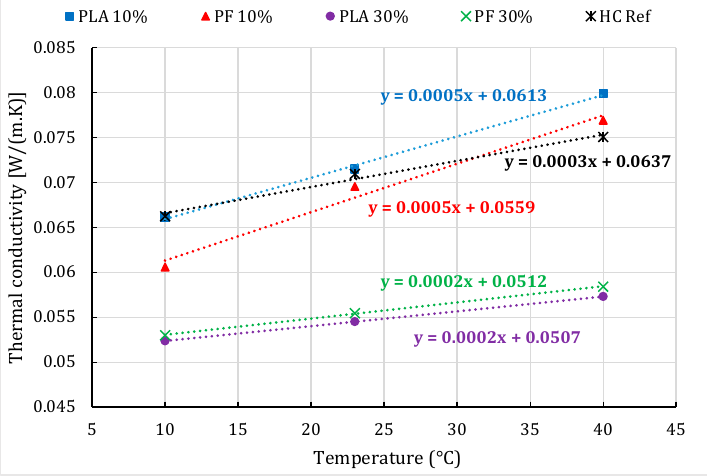
Figure 12. Thermal conductivity the reference hemp concrete (HC Ref) and the printed PLA and PF at 200 °C at two infills (10% and 30%).